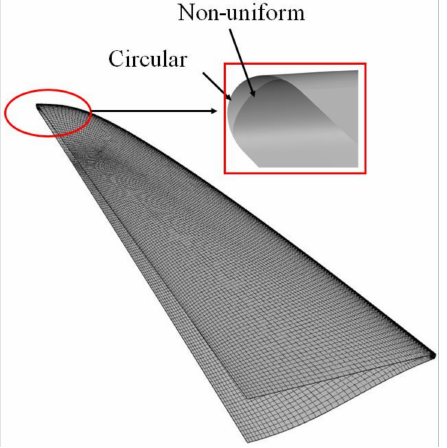
Figure 4. Bluntness methods and configuration of the